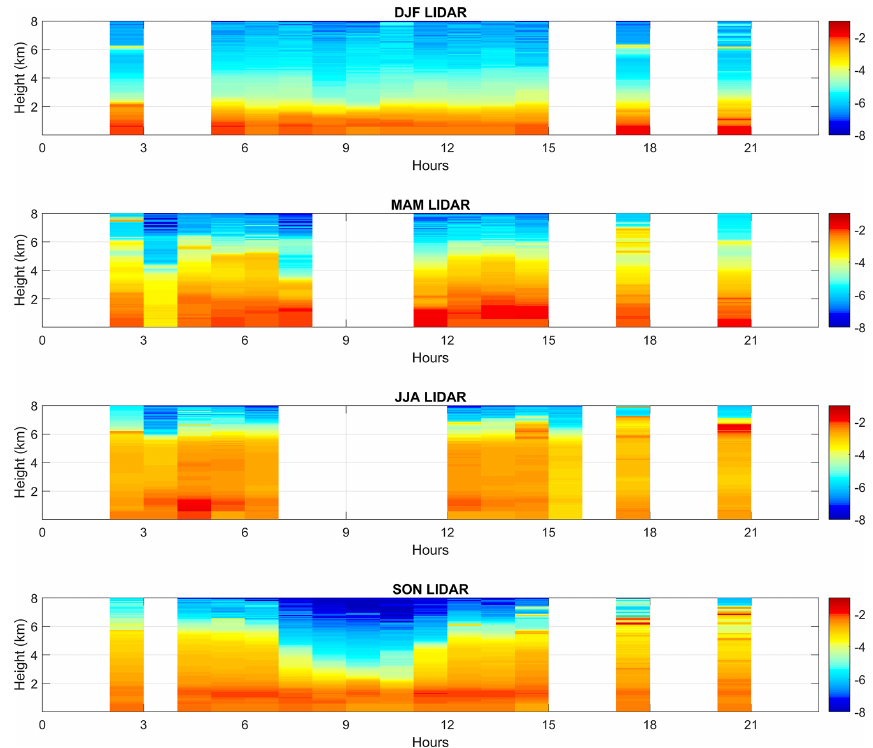
Figure 14. Diurnal profile of the natural logarithm of aerosol extinction coefficient at 532nm (km − 1 ) over the atmospheric column observed by the MPL at KAUST. Times are reported in